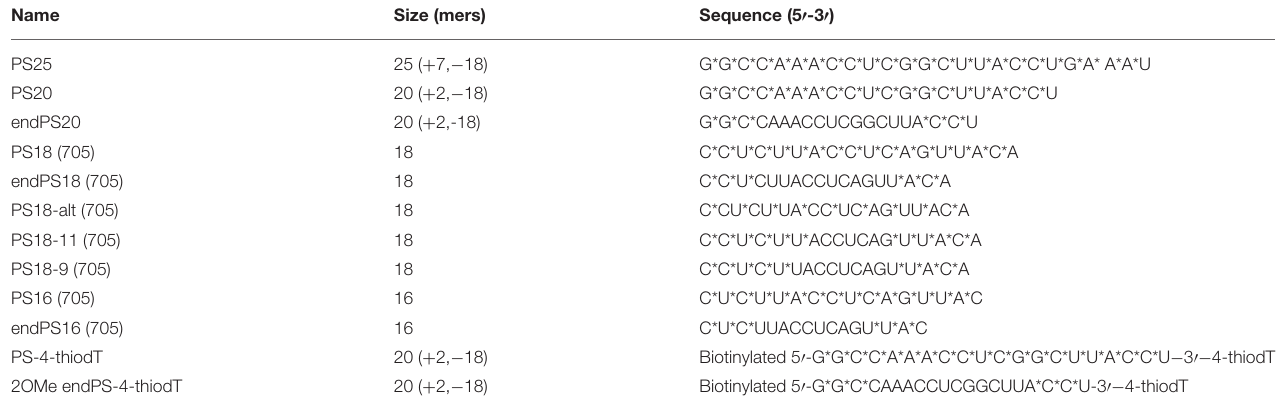
TABLE 1 | Nomenclature, size, and sequence of